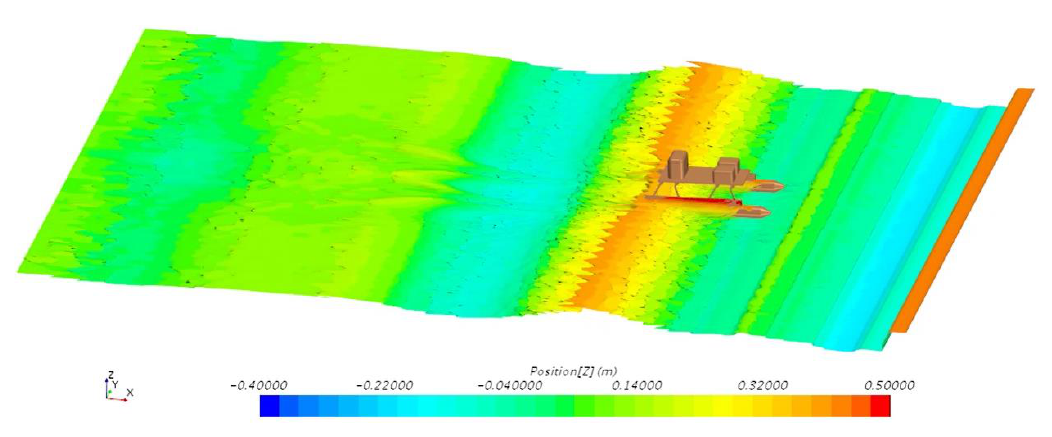
Figure 6. Numerical simulation results of the unmanned vehicle. Figure 7. Analysis of heave of the USV.